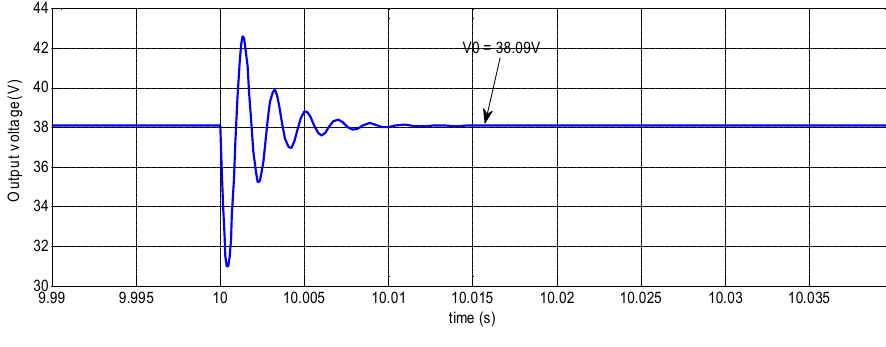
Figure 11. Output voltage at equilibrium.